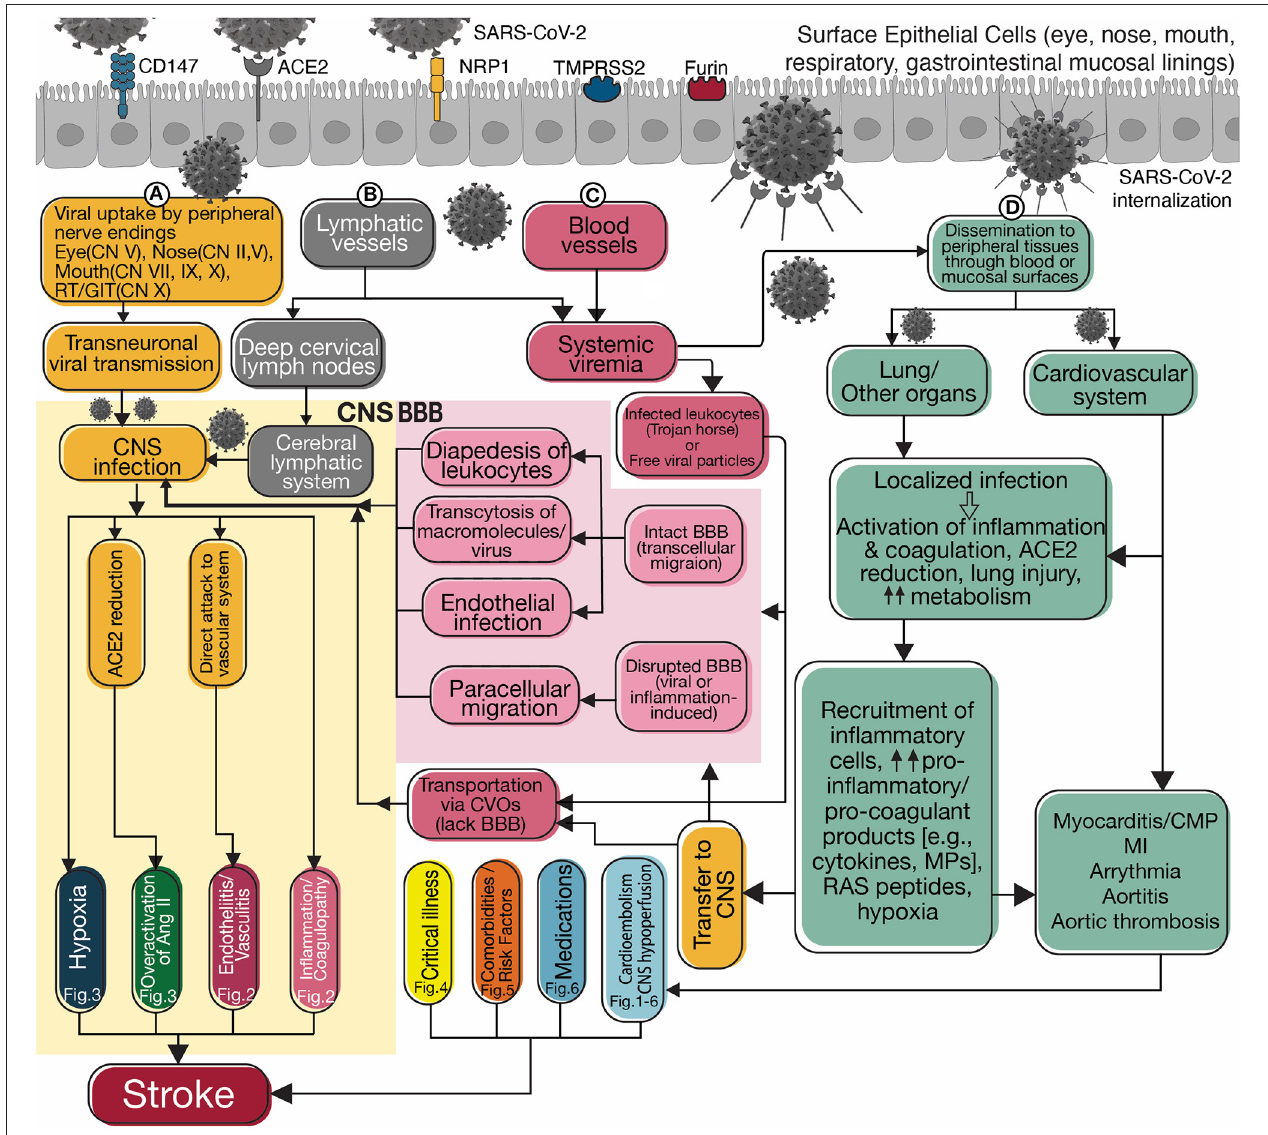
FIGURE 1 | Flowchart diagram summarizes possible routes for neuroinvasion and potential mechanisms of stroke. SARS-CoV-2 penetrates through its receptors, ACE2, CD147, or NRP1 and co-receptors, TMPRSS2, or FURIN present on the epithelial cells of the surface mucosal lining. Transportation occurs via viral invasion into (A) peripheral nerve endings and transneuronal transmission, (B) peripheral lymphatic vessels connected to the blood or cerebral lymphatic circulation, and (C) the blood vessels and invasion into the CNS (yellow box on the left). In blood, the virus spreads inside infected leukocytes (aka “Trojan horse”) or as free particles. Viral invasion through the hematogenous route requires crossing the intact blood-brain barrier (BBB) or penetrating the CNS through circumventricular organs (CVOs) that lack BBB. Intact BBB may allow a limited number of leukocytes to enter the CNS via transcellular diapedesis. Viral particles and macro-molecules can breach the BBB via receptor-mediated transcytosis or adsorptive transcytosis. Finally, SARS-CoV-2 can directly infect the endothelium and cross. A disrupted BBB enables unlimited paracellular transportation. Once In the CNS, the virus can invade the vascular system and increase stroke risk by causing endotheliitis/vasculitis ( Figure 2 ), activating the inflammation and coagulation cascades ( Figure 2 ), overactivation of angiotensin II signaling pathways ( Figure 3 ), or causing local hypoxia ( Figure 3 ). There is crosstalk between the inflammatory and coagulation systems in the central and peripheral environments because their products are transported bidirectionally. Viral invasion into peripheral tissues, including pulmonary and cardiovascular systems, occurs through direct mucosal surfaces or hematogenous dissemination (D) . Activation of inflammation and coagulation systems increases pro-inflammatory and pro-coagulant products, which are then transported to the CNS accompanying angiotensin II through BBB and CVOs. Lung and cardiovascular injury and elevated metabolism cause systemic hypoxia increasing the risk of stroke. Cardiovascular damage ( Figures 1 – 6 ) can cause a stroke by arrhythmia and cardioembolism or by decreased cardiac output resulting in cerebral hypoperfusion. Clinical features of critical illness ( Figure 4 ), especially in patients with some comorbidities or risk factors ( Figure 5 ) and side effects of certain medications ( Figure 6 ) may be related to increased risk of stroke. SARS-CoV-2, Severe acute respiratory syndrome coronavirus 2; CD147, Cluster of differentiation 147; ACE2, Angiotensin-converting enzyme 2; NRP1, Neuropilin-1; TMPRSS2, Transmembrane Serine Protease 2; CN, Cranial Nerve; RT, Respiratory tract; GIT, Gastrointestinal tract; CNS, Central nervous system; Fig, Figure; Ang II, Angiotensin 2; BBB, Blood-brain barrier; CVOs, Circumventricular organs; MPs, Microparticles; RAS, Renin-angiotensin system; CMP, Cardiomyopathy; MI, Myocardial